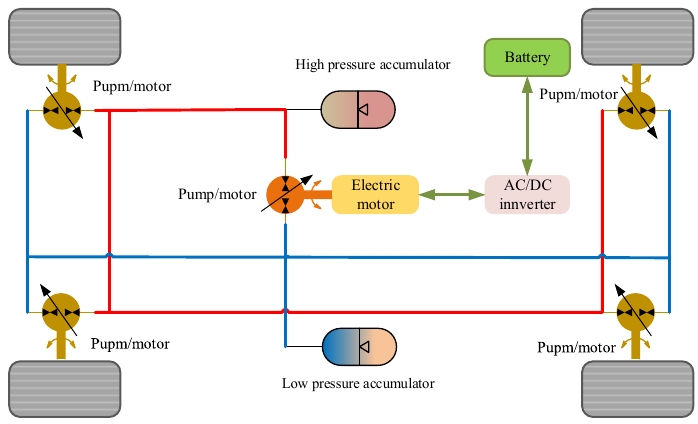
Figure 17. Structure of wheel ‐ drive hydraulic electric vehicles [108].